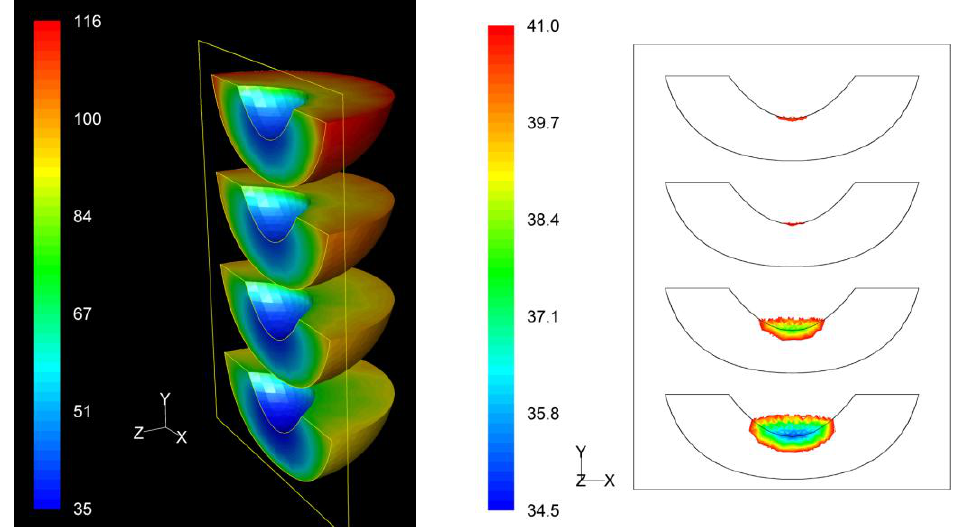
Figure 9. F value (in min) distribution within the peach halves (left) and location of the critical point (right) at the end of the thermal process for the “upward”